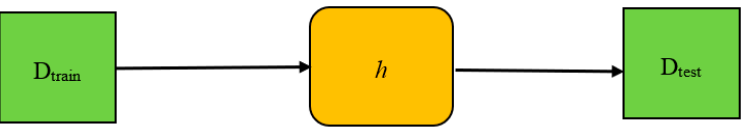
Figure 1. O ffl ine learning scheme. Both train and test sets are disjoint. Figure 1. Offline learning scheme. Both train and test sets are disjoint.